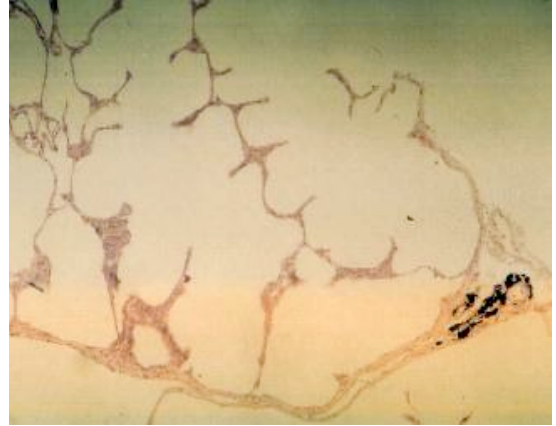
Image 14. Lung of Indian lion showing deposition of carbon particles, Anthracosis, H&E, 87.5x.